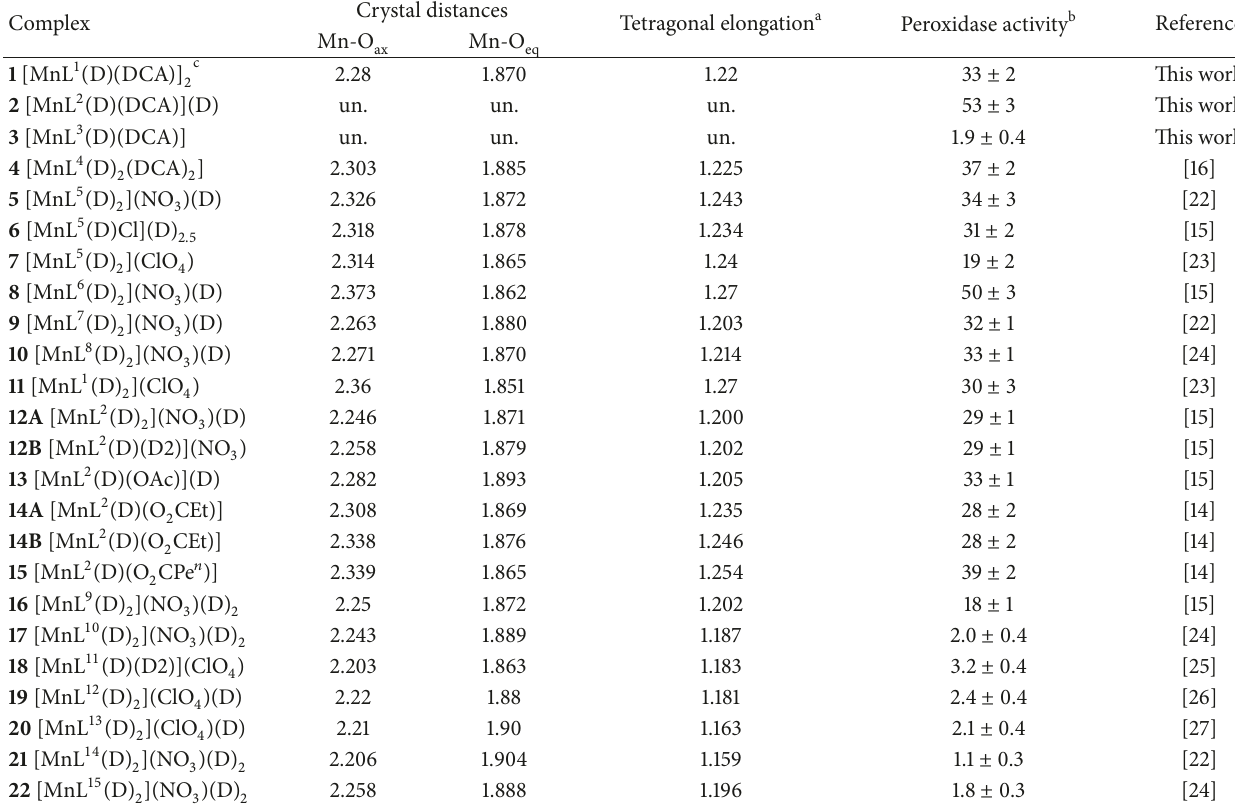
Table 6: Peroxidase activity for complexes 1 – 22 , axial and equatorial crystal distances around the manganese ion for each complex with solved crystallographic structure, resulting tetragonal elongation, and corresponding reference. Crystal distances Complex Mn-O eq